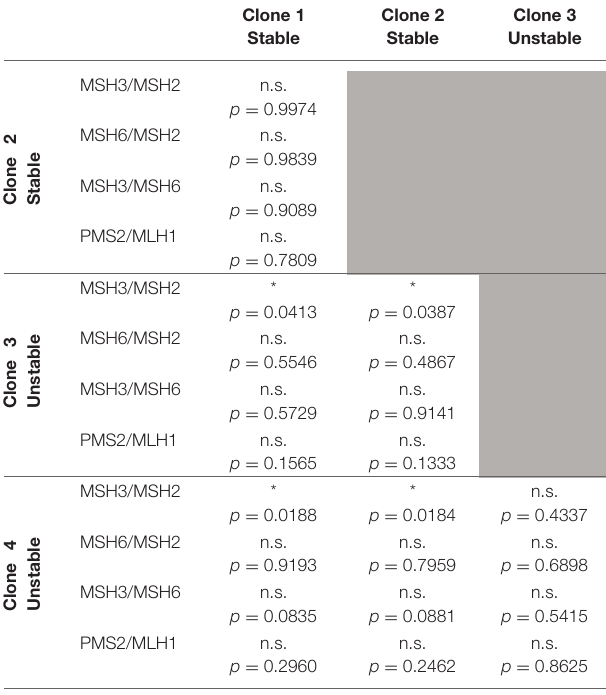
TABLE 1 | Population doubling times of D2763Kc2 progenitor culture, and clones derived thereof.